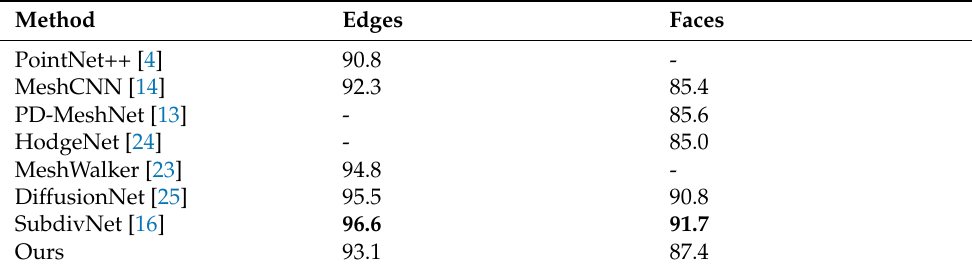
Figure 8. Our method can achieve more accurate boundaries for a human body dataset. Table 4. Segmentation results on human body segmentation with different